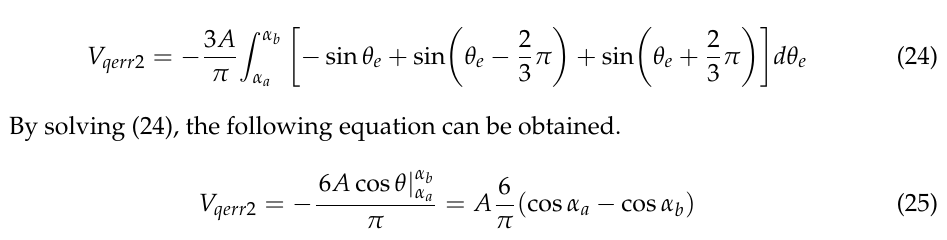
Figure 4. Diagram of d -axis nonlinear voltage. Figure 5 shows the waveform of the q -axis nonlinear voltage. The q -axis nonlinear voltage also varies three times in each electrical cycle. Therefore, the non-zero waveform integral between α a and α b can be calculated to obtain the equivalent value of the q -axis nonlinear voltage. As shown in Equation (24)